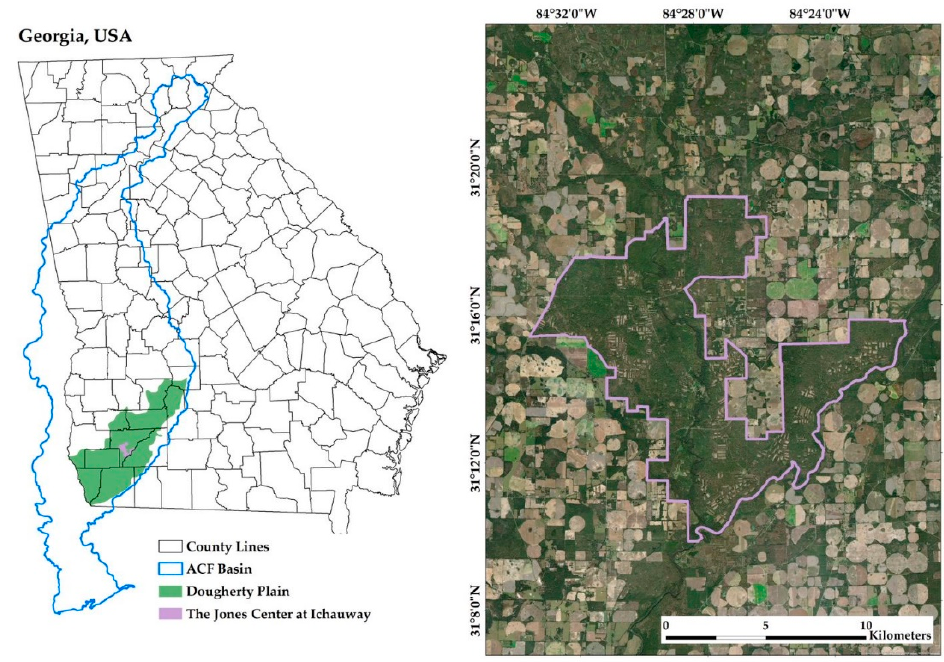
Figure 1. Maps showing the ACF basin, the Dougherty Plain, the Jones Center, and the study area. Latitude and Longitude coordinates: 31.220284, − 84.478656.